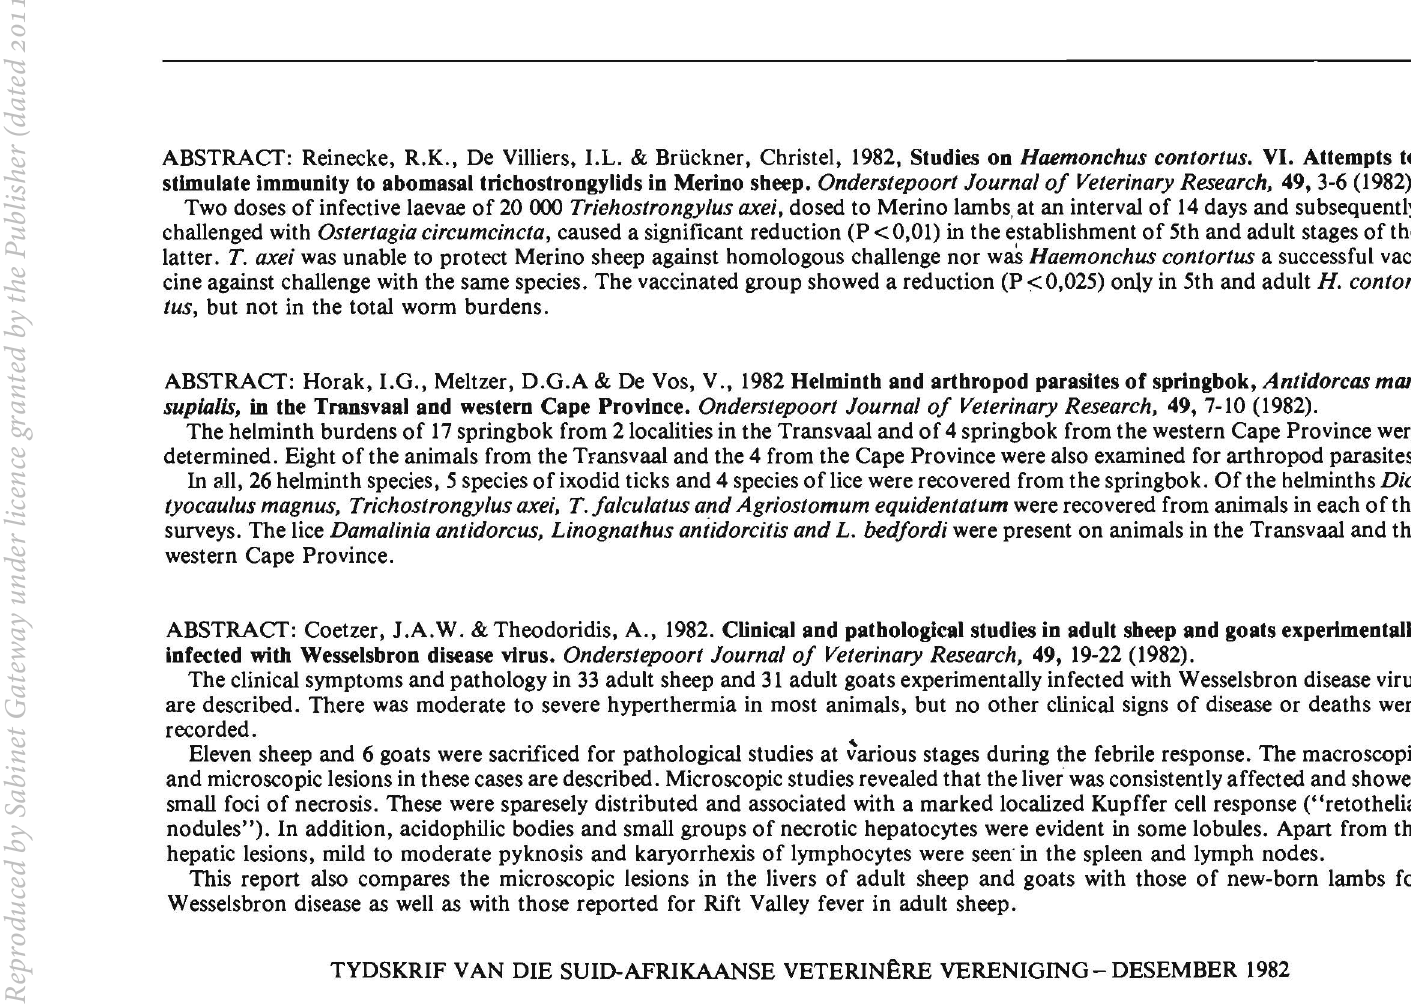
Fig. 2: Urethra In situ. Pelvic urethra a, penile urethra b, urethral diverticulum c, Ischial tuberosity d and pelvic symphysis